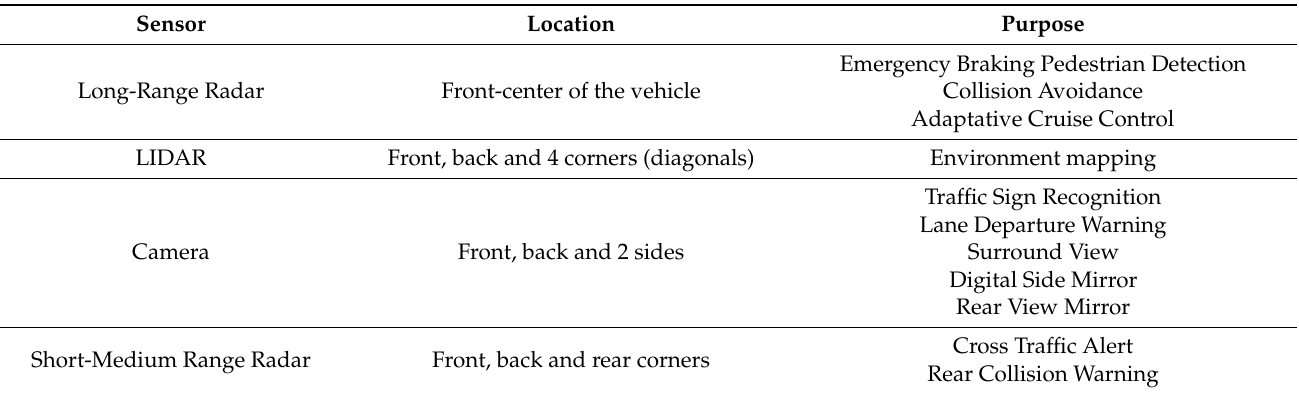
Table 5. Vehicle sensors, location and its